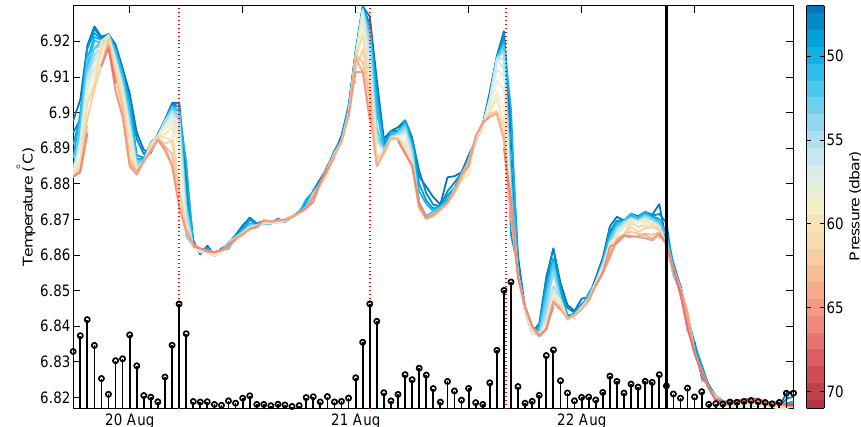
Figure 8. Seaglider temperature ( ◦ C) along isobars at 1dbar intervals from 45 to 71dbar, coloured by pressure. Vertical black stems indicate the difference between minimum and maximum values at each time step. This illustrates changes in vertical gradients; a small value indicates a homogenous BML, while a large value indicates a strong vertical gradient in the BML. We can clearly see events where the temperature gradient increases in the BML, showing injection of warmer surface water across the